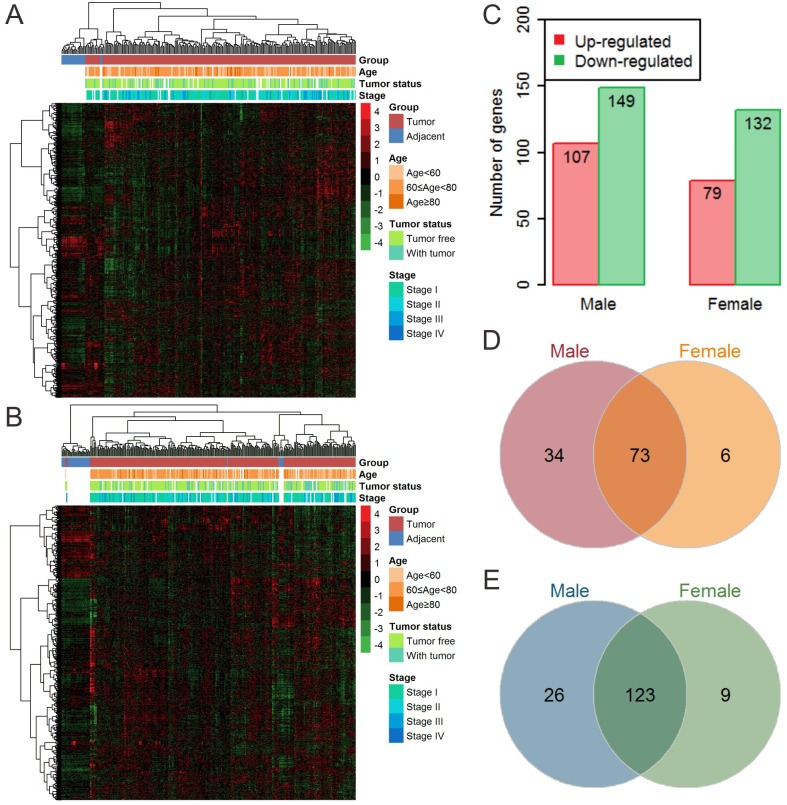
Overall metabolic gene expression profiles.(A) Heatmap of metabolic genes in males. (B) Heatmap of metabolic genes in females. (C) Number of upregulated and downregulated genes in males and females. (D) Venn diagram of upregulated genes in males and females. (E) Venn diagram of downregulated genes in males and females. All expression values were converted to z-scores.